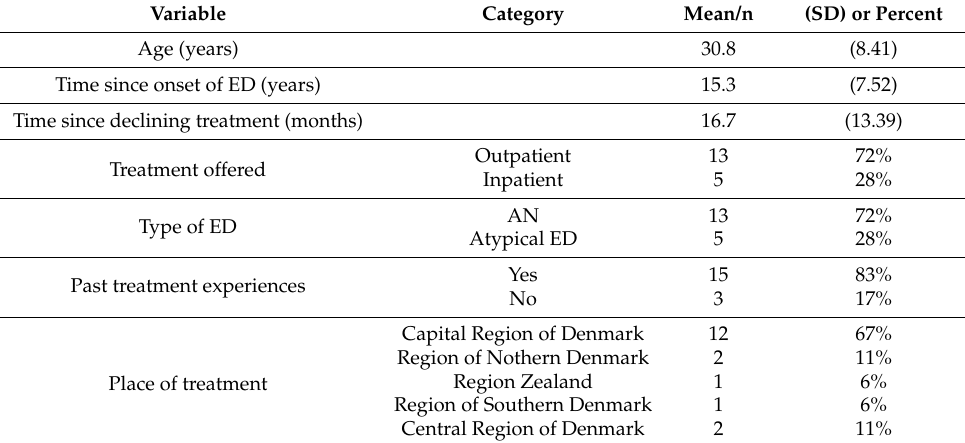
Table 1. Participant characteristics (self-reported